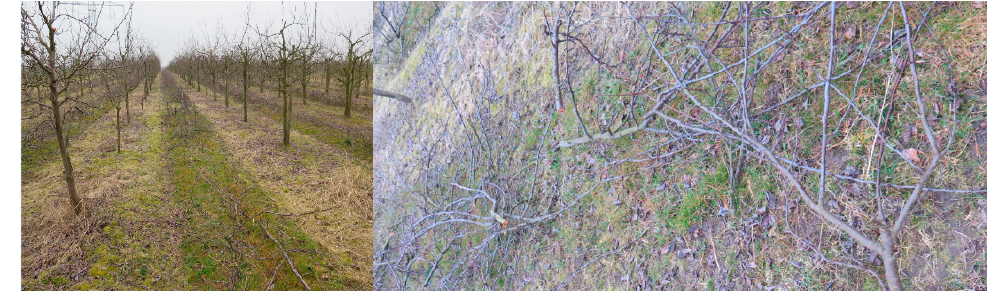
Figure 2. Plum tree pruning [12].